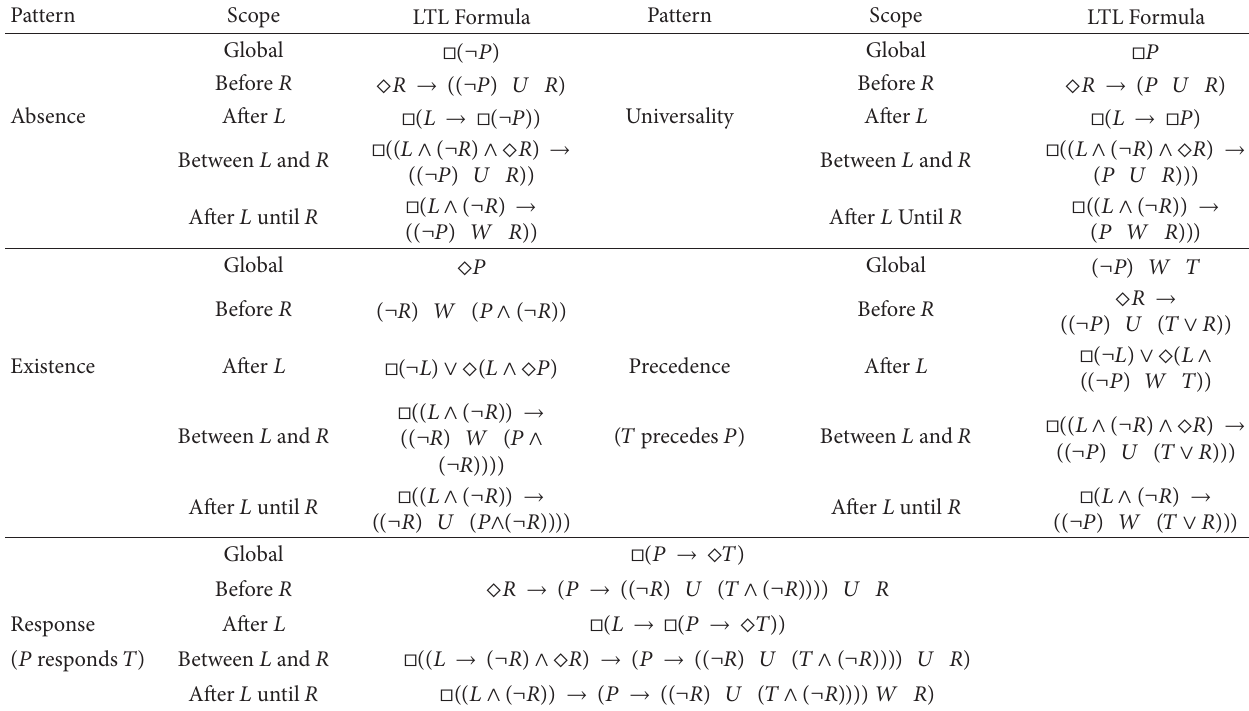
Table 1: LTL formulae in